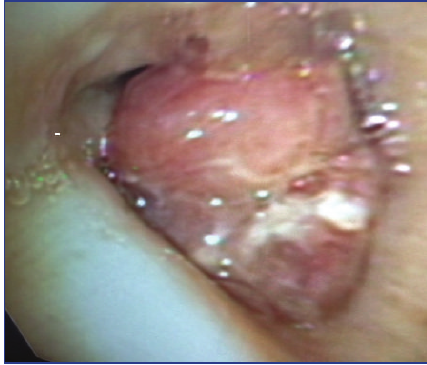
Figure 5: Cell block section of bronchoalveolar lavage show- ing hemosiderin-laden macrophages (granular golden pigment) demonstrating alveolar